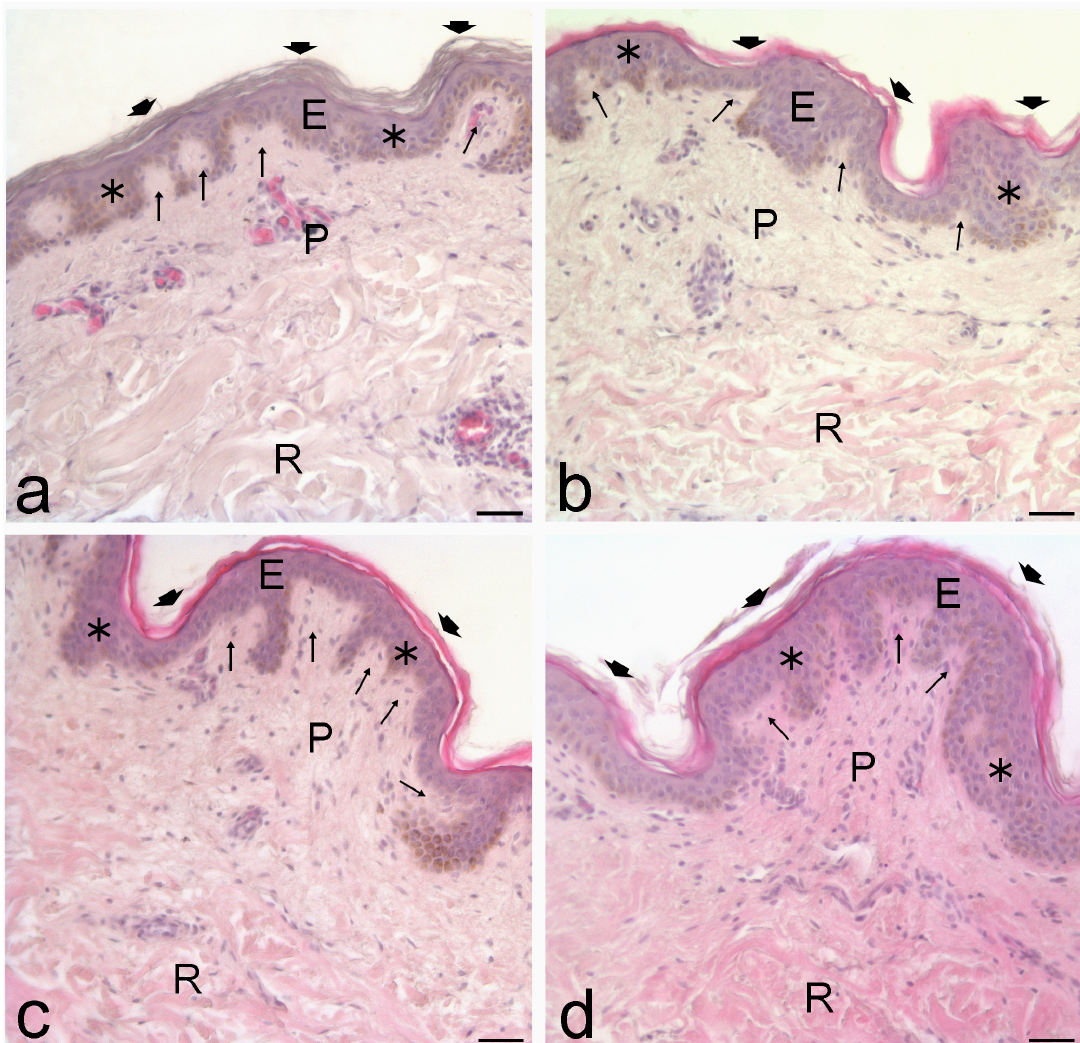
Figure 1. Bright-field microscopy images of human skin samples at T0 ( a ) and after 24 h ( b ), 48 h ( c ) and 72 h ( d ) in the bioreactor. E, epidermis; P, papillary dermis; R, reticular dermis. In the epidermis, arrowheads indicate the corneocytes’ layer, asterisks indicate the keratinocytes’ layers and arrows the dermal papillae. Bars: 50 µm.